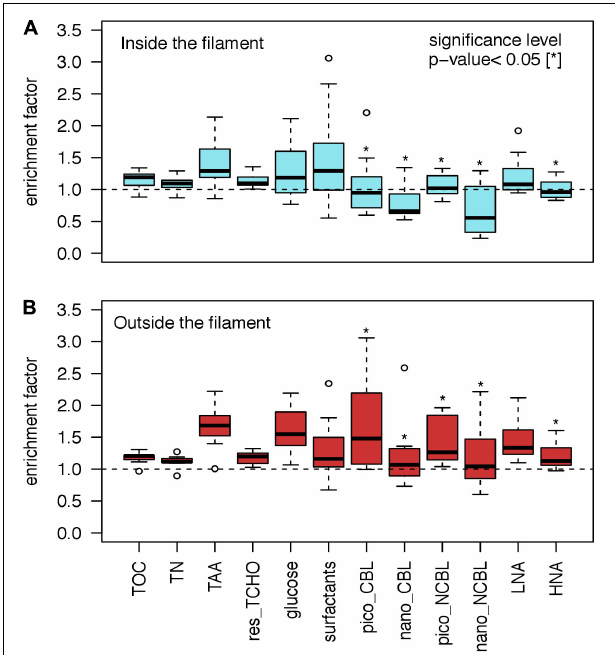
FIGURE 4 | Enrichment factors (EF) for biogenic substances and organisms comparing (A) inside and (B) outside the filament. For the comparison of differences in EFs between regimes the Mann–Whitney U -test was applied yielding significances ( p -value < 0.05) for all phytoplankton groups and HNA bacteria as marked by asterisks. Total organic carbon (TOC); total nitrogen (TN), total amino acids (TAA); total combined carbohydrates excluding glucose (res_TCHO); cyanobacteria like phytoplankton cells (CBL); non-cyanobacteria like phytoplankton cells (NCBL); pico ( < 2 µ m); nano ( > 2 µ m); low nucleic acid content bacteria (LNA); high nucleic acid content bacteria